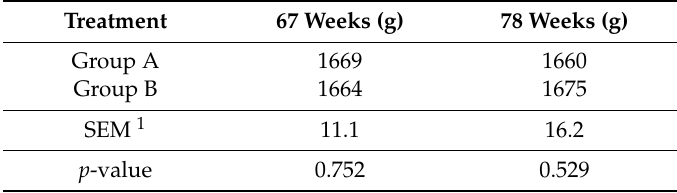
Table 7. Body weight (g) of laying hens fed a commercial diet (Group A) or a soy-free diet + live larvae (Group B) from 67 to 78 weeks of age.